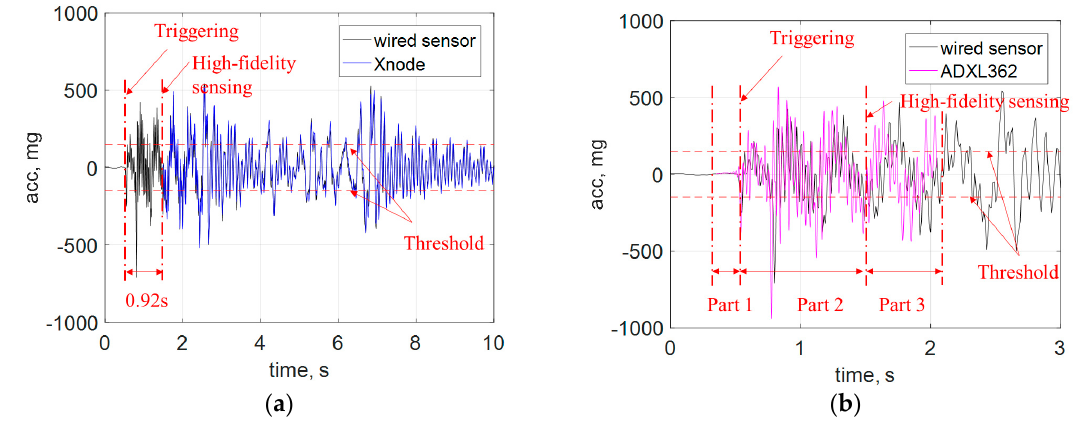
Figure 7. Time history data comparison: ( a ) Xnode measurement, ( b ) ADXL362 data buffer.